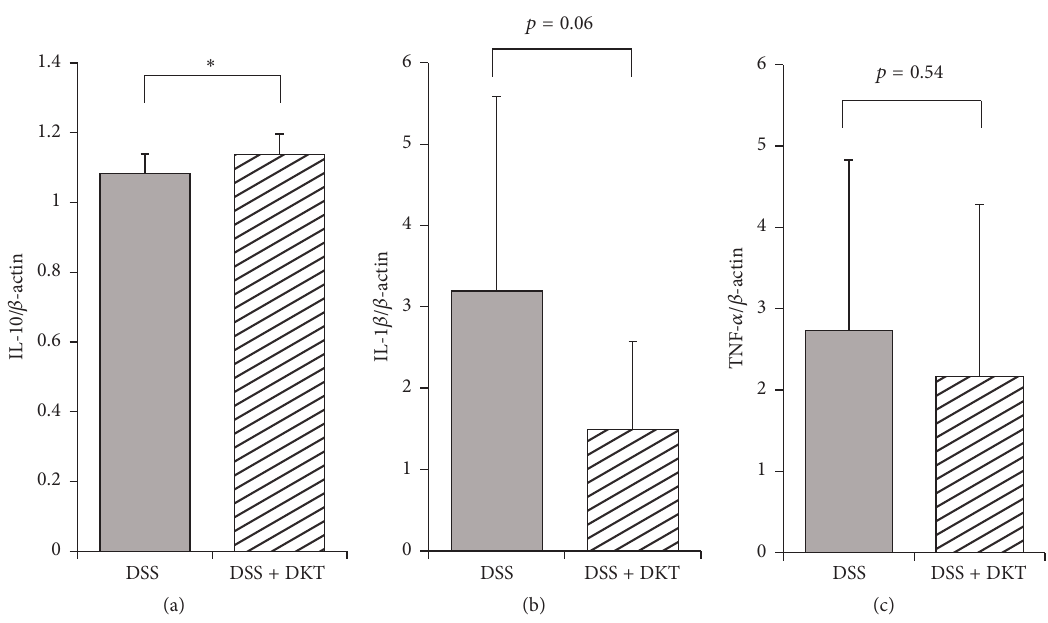
Figure 6: Anti-inflammatory and inflammatory cytokine levels of each study group. (a) Interleukin- (IL-) 10. (b) IL-1 𝛽 . (c) Tumor necrosis factor- (TNF-) 𝛼 . Normal group, untreated mice. Dextran sulfate sodium (DSS) group, mice administered 5% DSS for 7 days. DSS + daikenchuto (DKT) group, mice provided with DKT in addition to DSS. 𝑛 = 10 mice (for normal, DSS, and DSS + DKT groups). ∗ 𝑝 < 0.05